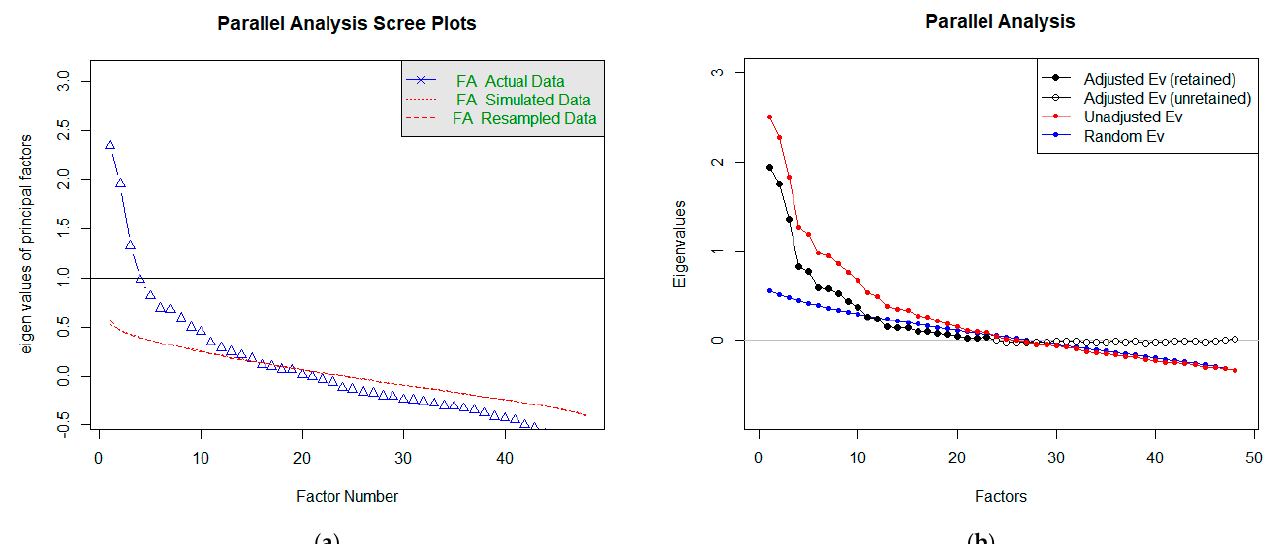
Figure 7. Representation of Parallel Analysis Scree plots to determine the number of factors.